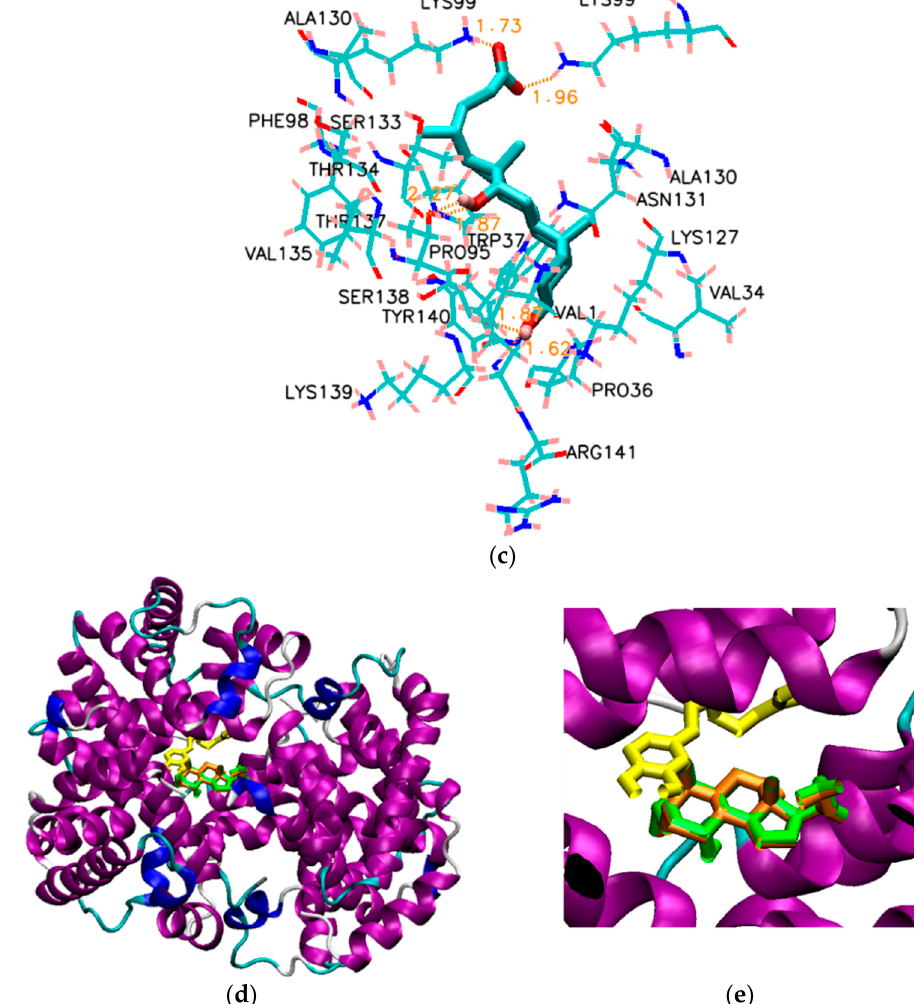
Figure 6. ( a ) CAPE and its surrounding amino acid residues for CAPE–Hb system; ( b ) NaC and its surrounding amino acid residues for NaC–Hb system; ( c ) NaDC and its surrounding amino acid residues for NaDC–Hb system; ( d ) The whole simulation diagram of Hb docking with CAPE, NaC and NaDC; ( e ) Partial enlargement of Figure 6d. The spiral is the carbonmonoxy liganded bovine Hb (PDB: 1G09 at pH 7.2), the yellow rod is CAPE, the green rod is NaC and the orange rod is NaDC.